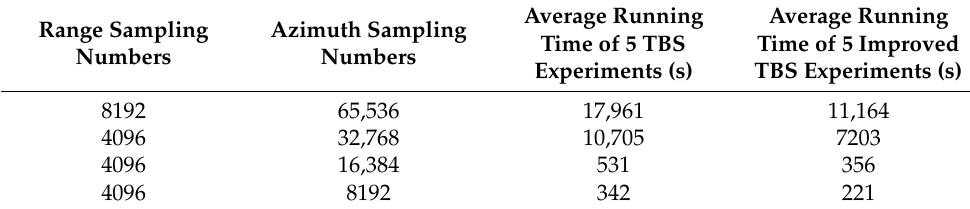
Table 2. Running time of